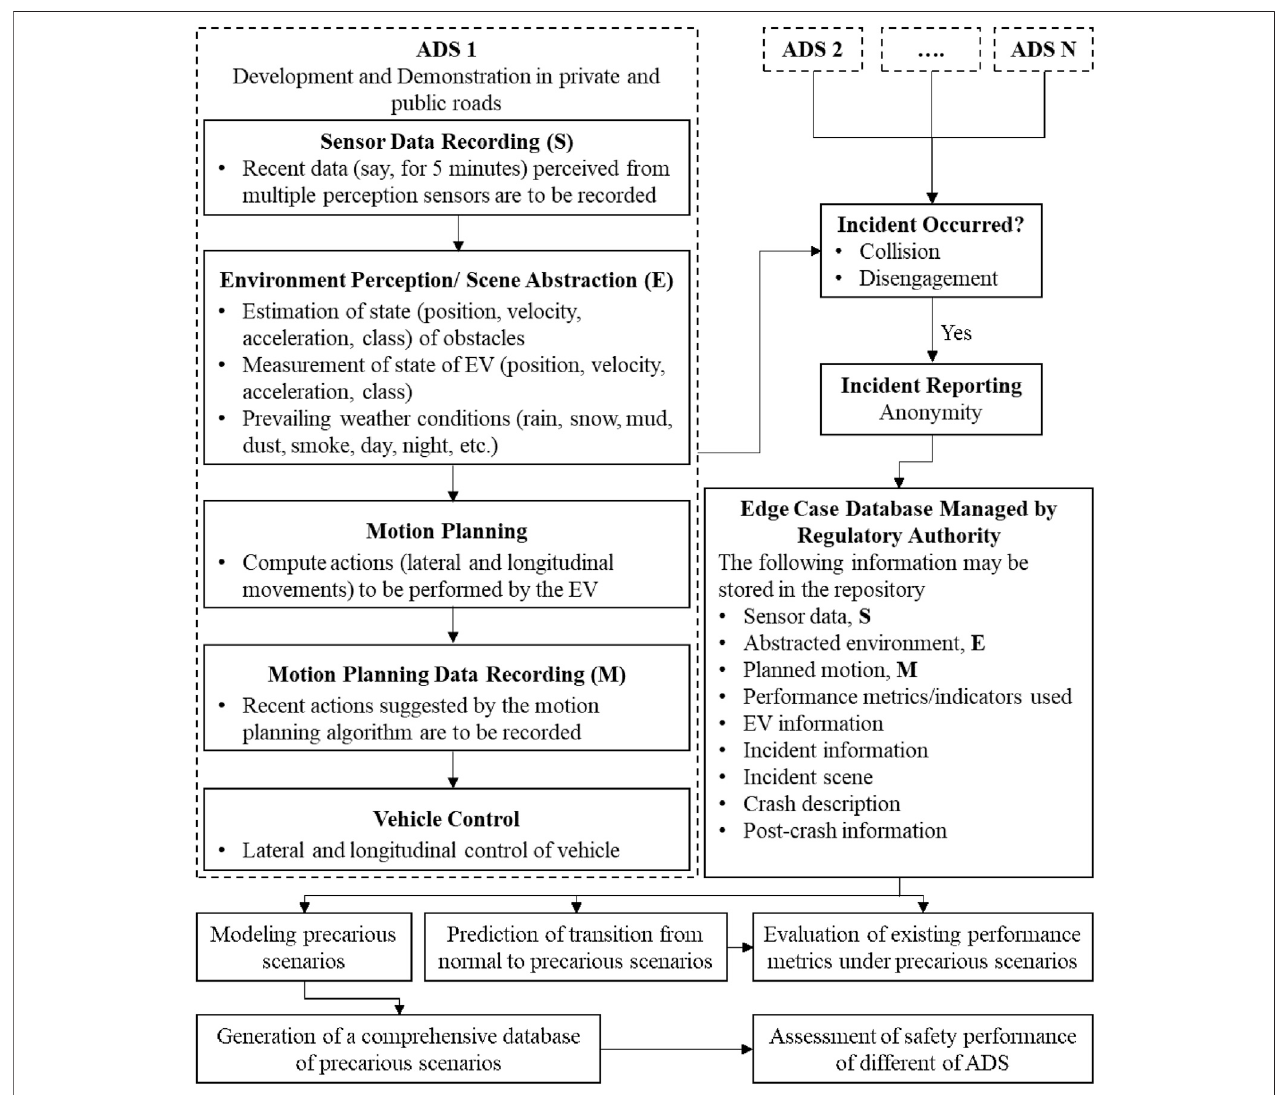
FIGURE 7 | Framework for collecting precrash sequences and its